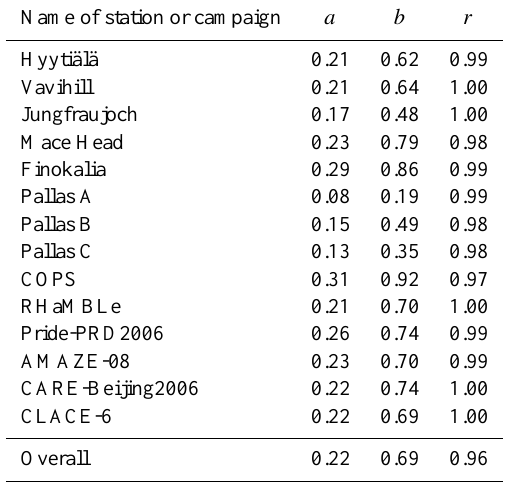
Table 4. Parameters of the linear fit A = a × ln (S eff ) + b , for all locations depicted in Fig. 4. a is the slope, b is the intercept and r is the correlation coefficient of the simple linear regression. The overall linear fit is based on most of the activation curves depicted in Fig. 4, except Finokalia, COPS, Jungfraujoch and Pallas A, B and